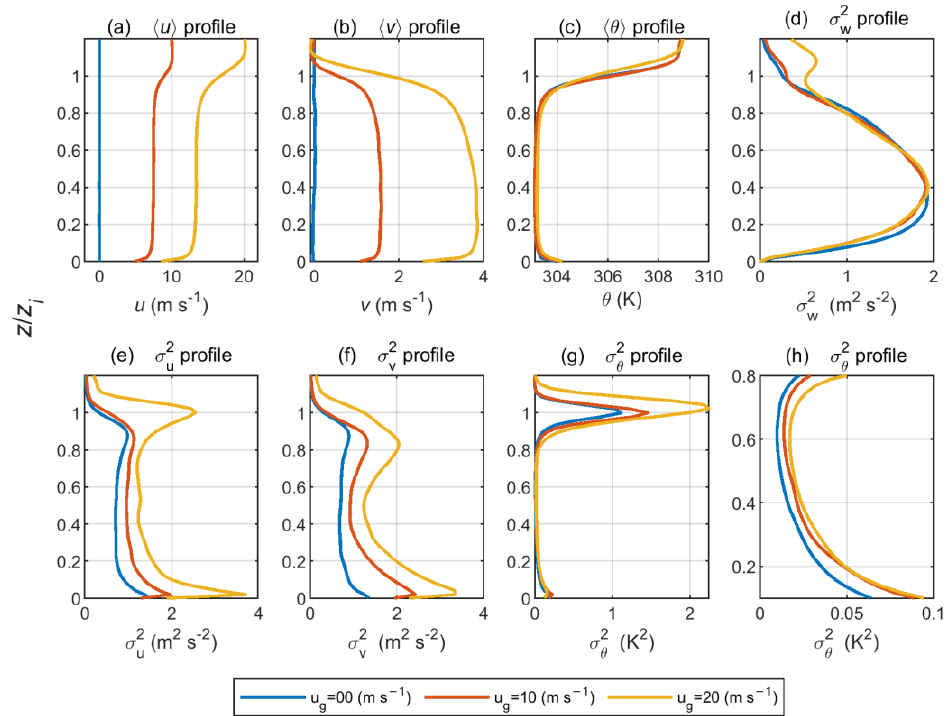
Figure 2. The vertical profiles of horizontal averaged u ( a ), v ( b ), and θ ( c ), and variances of w ( d ), u ( e ), v ( f ), and θ ( g , h ) from LES simulations at z / z i = 0.5 and 3 h of physical time. The blue, red, and yellow lines represent the geostrophic wind forcing of U g = 0, 10, and 20 ms −1 , respectively. The w variance ( σ 2 , Figure 2d), u variance ( σ 2 , Figure 2e), v variance ( σ 2 , Figure 2f), w u v and θ variance ( σ 2 , Figure 2g) are examined throughout the height of the CBL. For a fixed θ value of z / z i and a constant Q 0 , 𝜎 𝑤2 differs insignificantly, whereas 𝜎 𝑢2 and 𝜎 𝑣2 increase monotonically with an increasing U g , suggesting that the TKE vertical component, σ 2 , w remains nearly identical, and the TKE horizontal components, σ 2 and σ 2 , become larger u v with an increasing U g , which is consistent with the results of Salesky et al. [26]. shear; otherwise, an increase in 𝜎 𝑤2 , i.e., an increase in w fluctuations, will lead to an